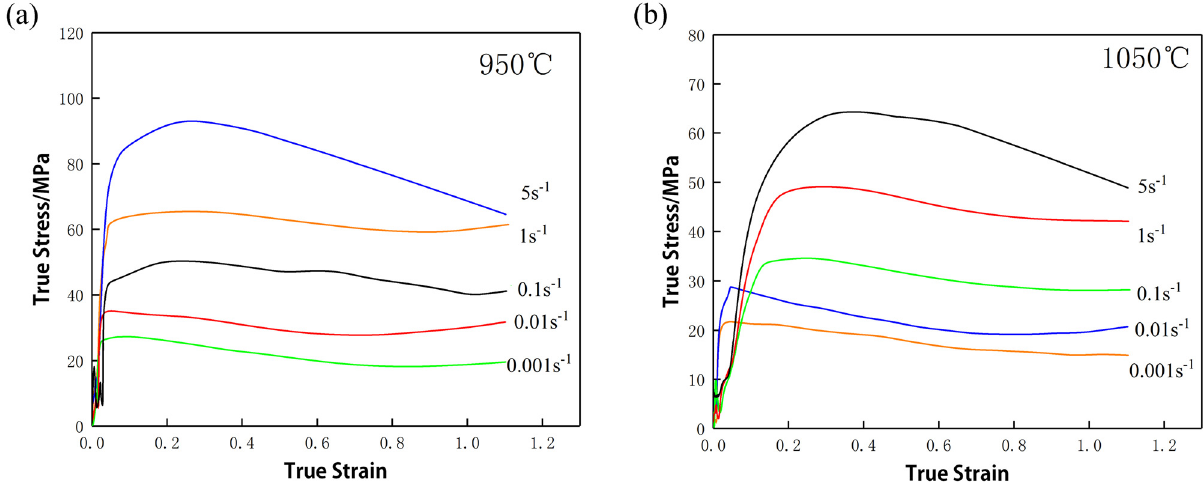
Figure 4: True stress – true strain curve of TC4 titanium alloy at di ff erent strain rates ( a ) 950°C and ( b ) 1,050°C.